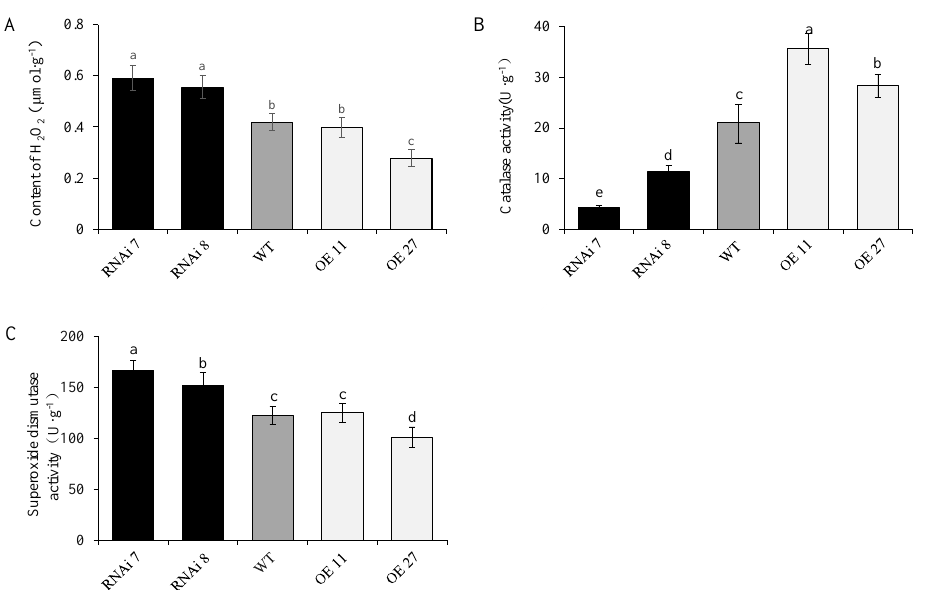
Figure 7. Effect of StSN2 on H 2 O 2 content ( A ), superoxide dismutase (SOD) activity ( B ) and catalase (CAT) activity ( C ) in the three periderms. Data are means ± SD of three biological replicates. Different lowercase letters indicate a significant difference at p < 0.05 by Duncan’s test analysis.